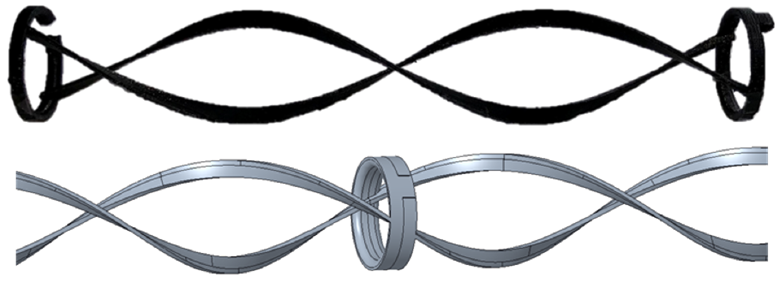
Figure 4. 3D-print of a helical fin module ( top ) and snapshot of the CAD model ( bottom